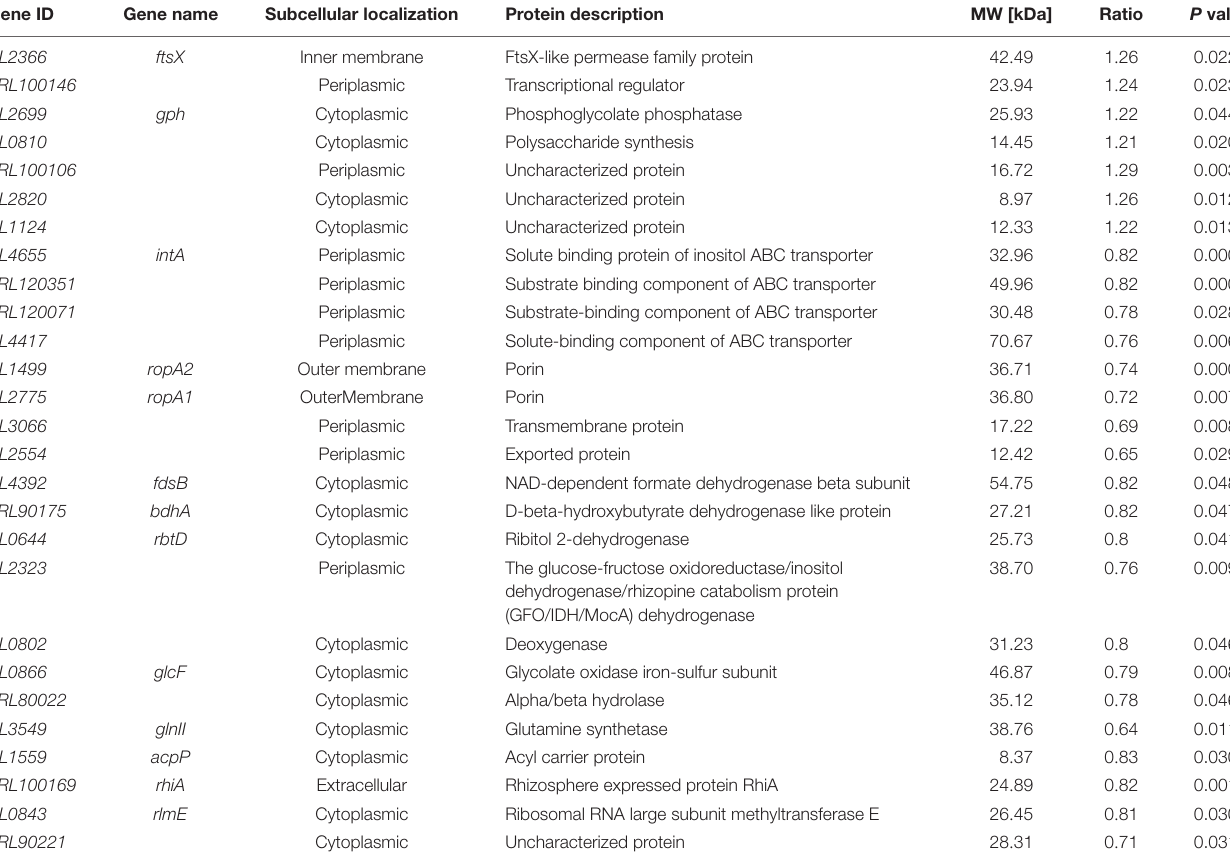
TABLE 4 | Differential expression proteins in mutant-induced nodule bacteroids relative to wildtype-induced nodule